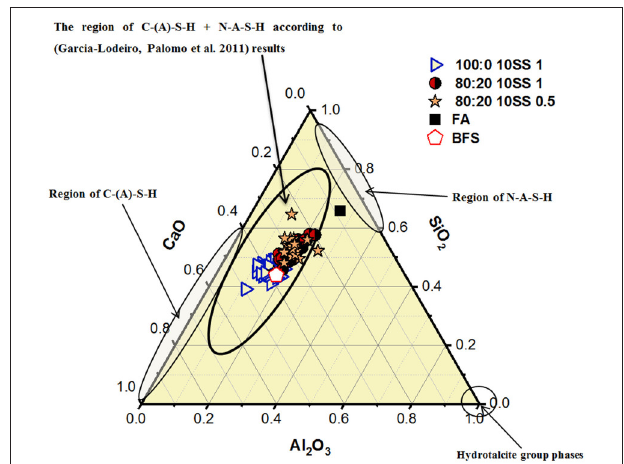
FIGURE 10 | SEM-BSE images of 1 year old concrete samples. FA, Unreacted or partially reacted fly ash particle; BFS, Unreacted or partially reacted blast furnace slag particle; RFA, full reacted Fly ash particle; Agg, aggregate particle.